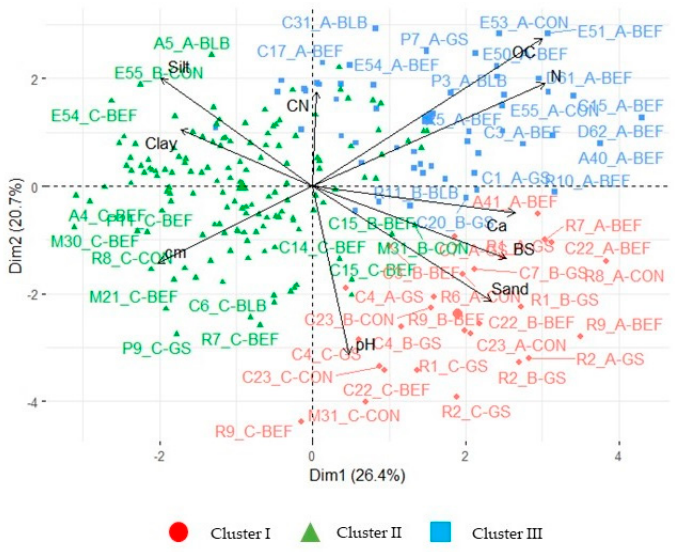
Figure 3. Principal component analysis (PCA) obtained from the dataset at a 1000–2134 m altitudinal range. The distinct colors identified the three clusters distributed along principal components (Dim) 1 and 2. The sample codes included the sampling area, profile number, layer, and vegetation cover. The variables are in black. BS = base saturation; Ca = exchangeable Ca; N = total N; OC = soil organic C; CN = OC–to–N ratio; cm = microbial biomass